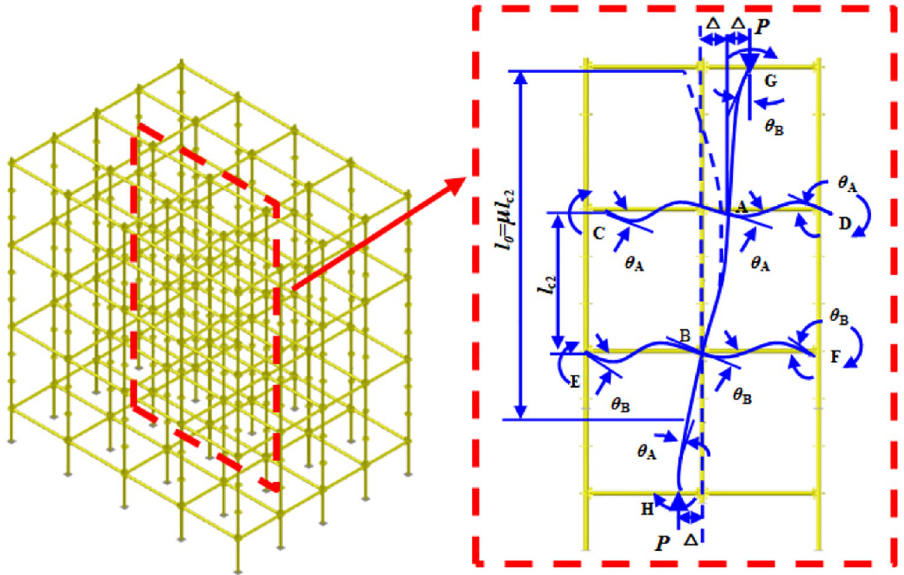
Fig 1. Calculation diagram of the substructure of the sway formwork